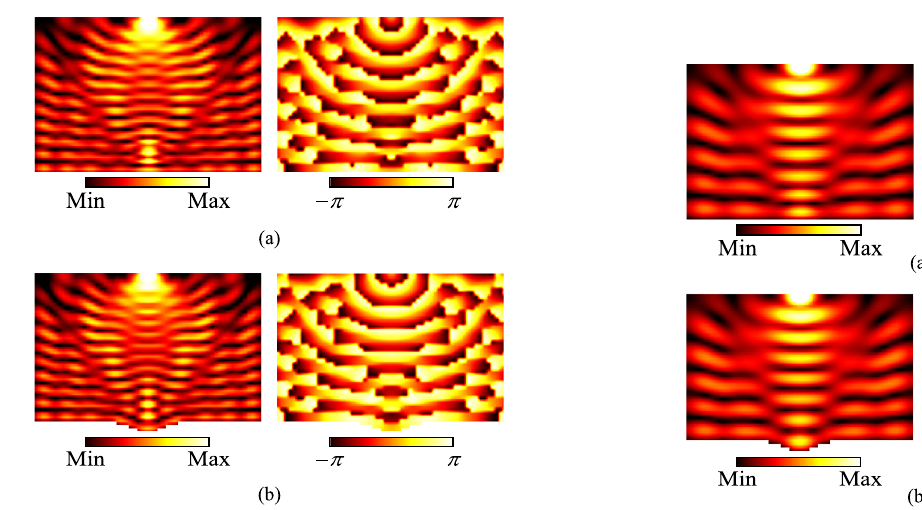
Fig. 21. Calculated complex voltage distributions corresponding to measured results in Figure 20. Left: Amplitude. Right: Phase. (a) With the groove illusion medium. (b) With the original groove.